Question: Generate an informative caption for the figure above.
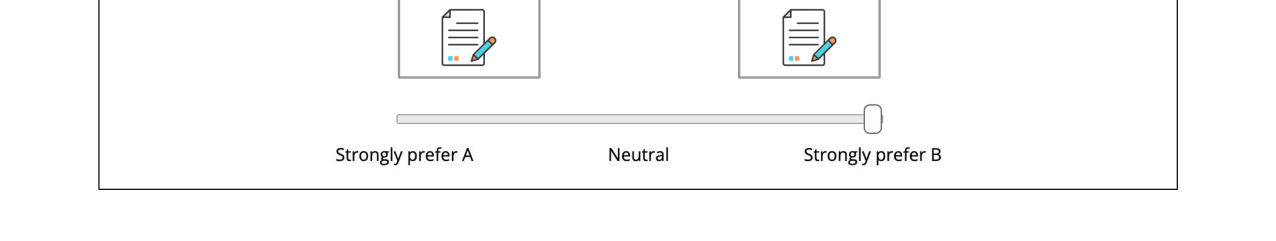
Answer: The evaluation task description for teachers. In each evaluation, we ask the teacher to compare two worksheets in terms of their effectiveness in improving the student’s test performance, and we show the teacher two sample test questions. Teachers can indicate their preference by adjusting the slider.